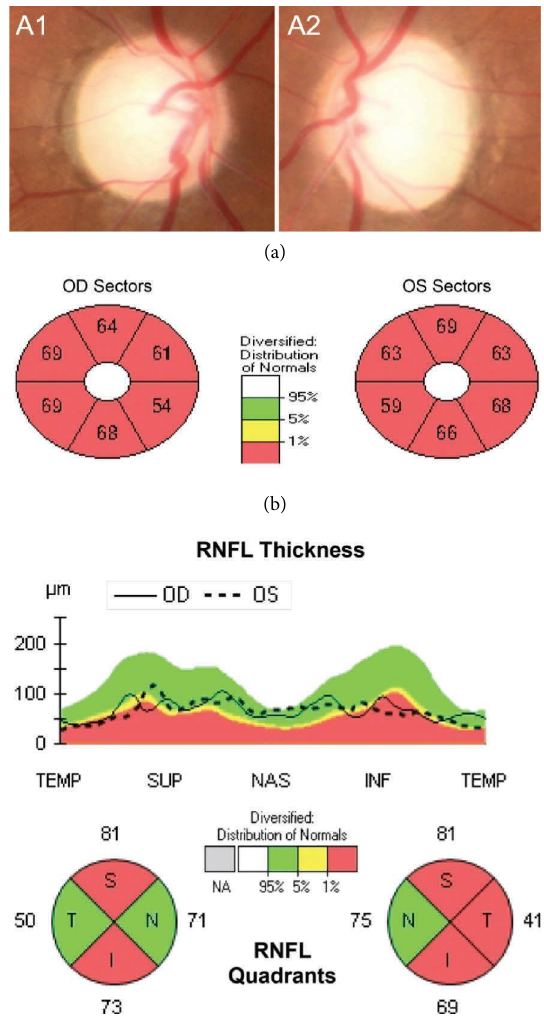
Figure 6: Obvious mGCL +IPL thinning, pRNFL thinning, and optic disc pallor were found in the late course of methanol-induced optic neuropathy. (a) Te pale optic nerve is found in the fundus photograph. (b) OCTidentifed severe mGCL +IPL thinning. (c) OCTidentifed severe pRNFL